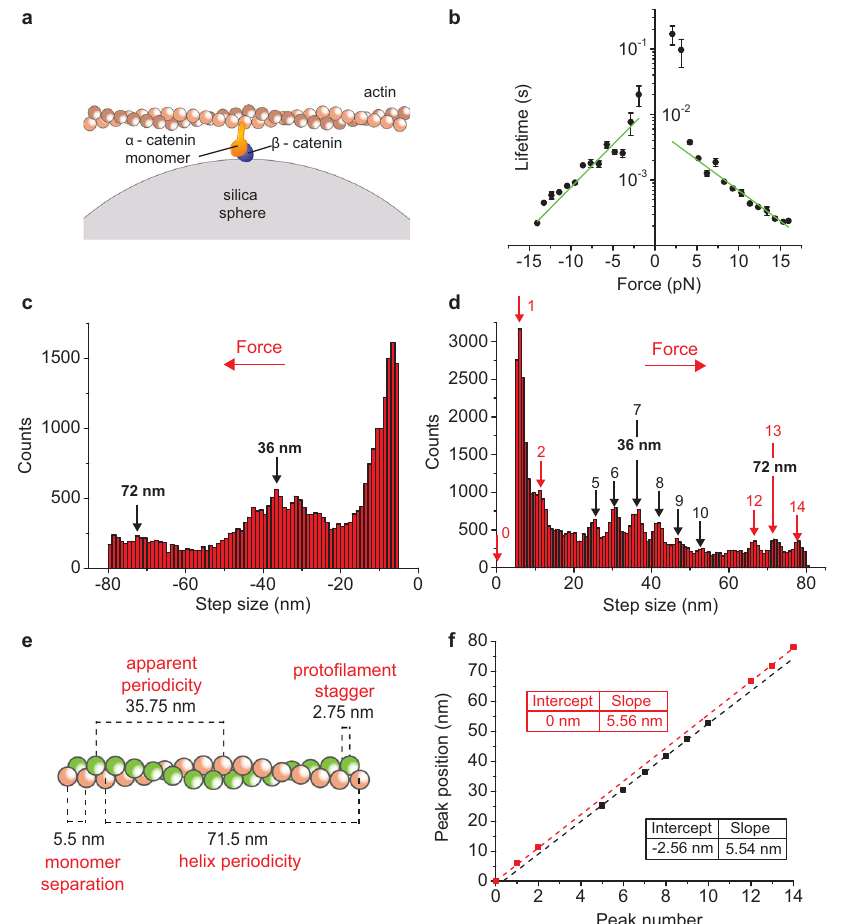
Fig. 2 A single α - β -catenin heterodimer forms a slip bond with F-actin that does not bear force. a Schematic of ultrafast force-clamp spectroscopy applied to a single α - β -catenin heterodimer. The single heterodimer is composed by a single monomeric His(6x) tagged α -catenin attached onto a layer of GST-tagged β -catenin (see methods). b Load-dependent lifetime of the interaction between a single α - β -catenin heterodimer and F-actin. Green lines are (cid:1) (cid:3) d ± αβ F fi ts of lifetimes τ with the Bell-bond equation τ ¼ τ ± exp (cid:2) (see Methods). Fitting parameters are d αβ + = 0.88 ± 0.05 nm, d αβ - = 1.22 ± 0.08 nm, k B T 0 + = 6.1 ± 0.8 ms, τ = 16 ± 4 ms. n = 360486 total number of interactions for all points in the plot. Error bars, s.e.m. c , d Distribution of step size vs. force τ 0 0 - for negative ( c ) and positive force ( d ). e Illustration showing the actin fi lament structure and highlighting the two proto fi laments (red and green), the helix and apparent periodicity, the distance between consecutive monomers on the same proto fi lament, and the stagger between monomers on two consecutive proto fi laments. f Plot of the position of peaks obtained from the step histogram in ( d ) against peak number. Red squares correspond to monomers on the same proto fi lament. Black squares correspond to monomers on the adjacent proto fi lament. Red and black dashed lines are the least-squares fi ttings of the red and black points, giving slopes of 5.56 ± 0.01 and 5.54 ± 0.04 nm/monomer respectively, and stagger between proto fi laments of 2.56 ± 0.31 nm. Errors, s.e.m. Source data are provided as a Source Data fi